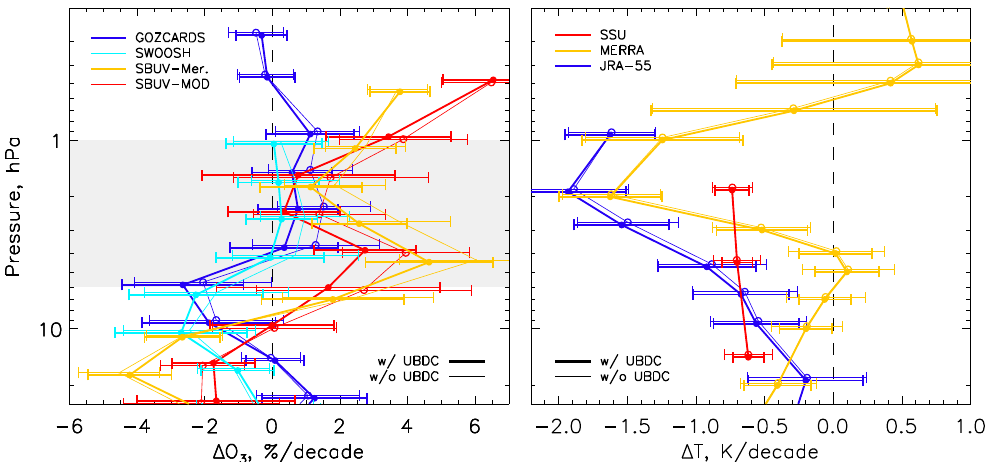
Figure 13. Equatorial stratospheric decadal trend profiles for (left) SWOOSH (light blue), GOZCARDS (blue), SBUV-Mer. (yellow), and SBUV-MOD (red) ozone between 1998 and 2012, and (right) for SSU (red), MERRA (yellow), and JRA-55 (blue) temperature between 1983 and 2005. Thin lines and circles represent profiles without the UBDC index; thick lines and filled circles are with the UBDC index. The change in error bars are the same reduction in the error bar between using and not using the UBDC index as in Fig. 10. Profiles have been offset slightly from the actual pressure levels for